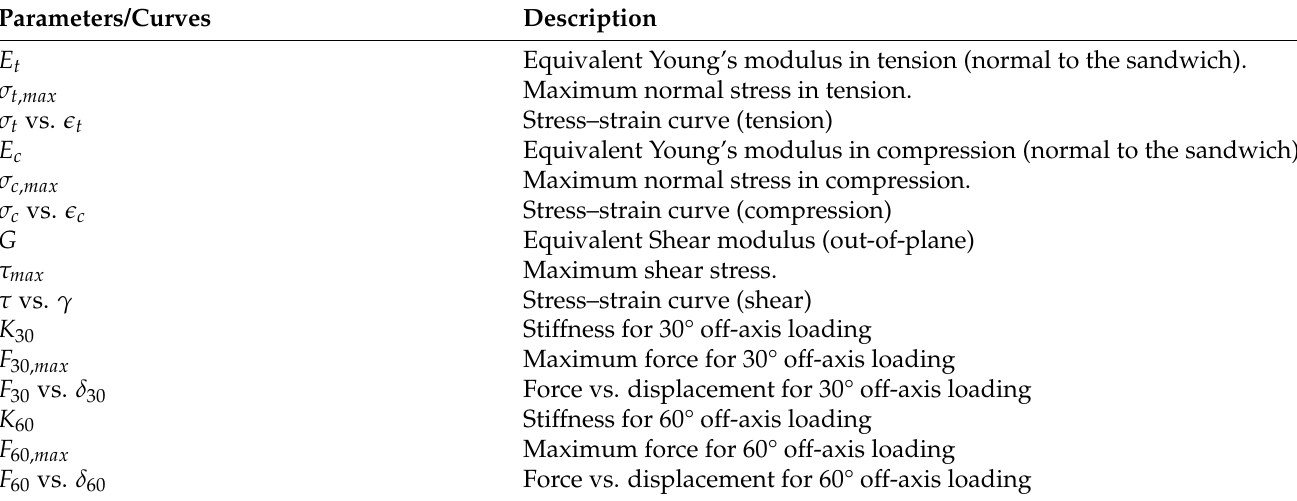
Table 3. Parameters and curves to be determined in the